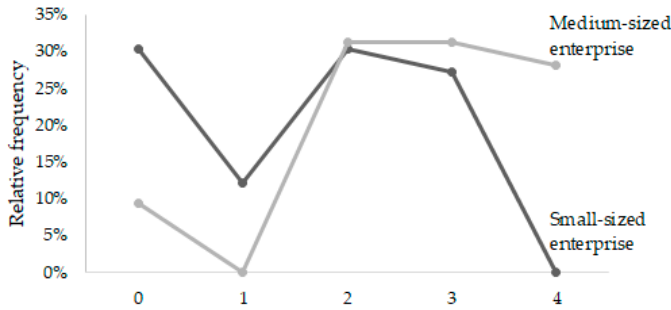
Figure 6. Interaction plot of the relative frequencies of the number of types of introduced innovation grouped by the size of the family business.